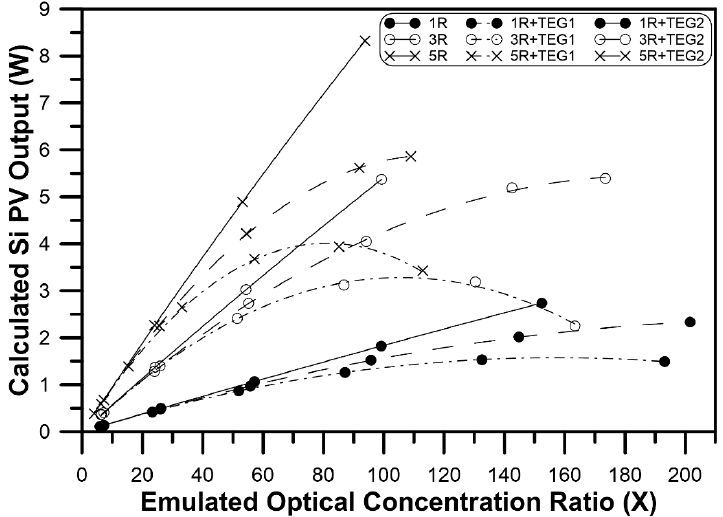
Figure 9. Electrical output of the LGBC silicon concentrator PV cell.